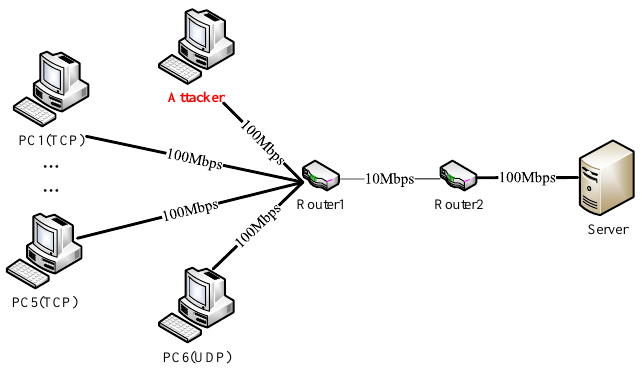
Figure 13. Topology of testbed.